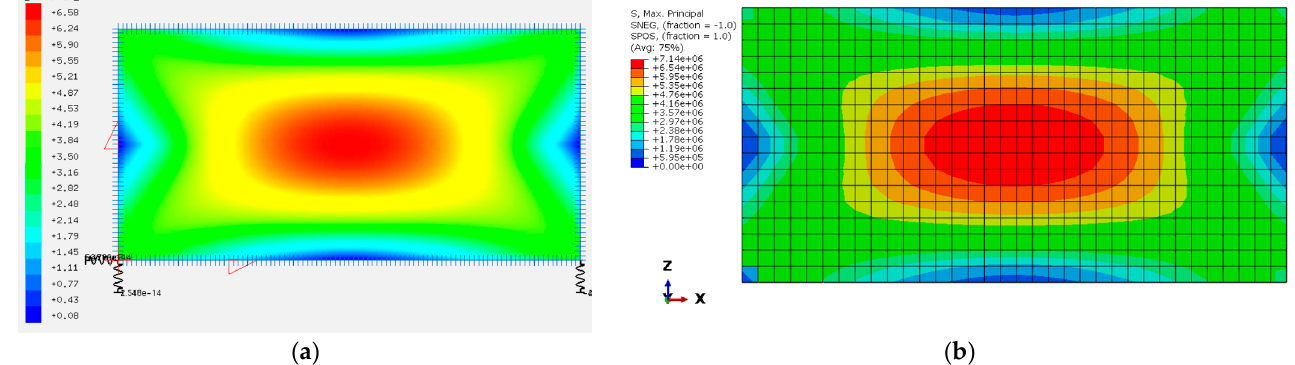
Figure 4. Validation of the flat IGU model (‘summer’ load case): ( a ) maximum principal (tensile) stress obtained from the SJ-Mepla software (values in MPa); ( b ) maximum principal (tensile) stress obtained from the ABAQUS software (values in Pa).